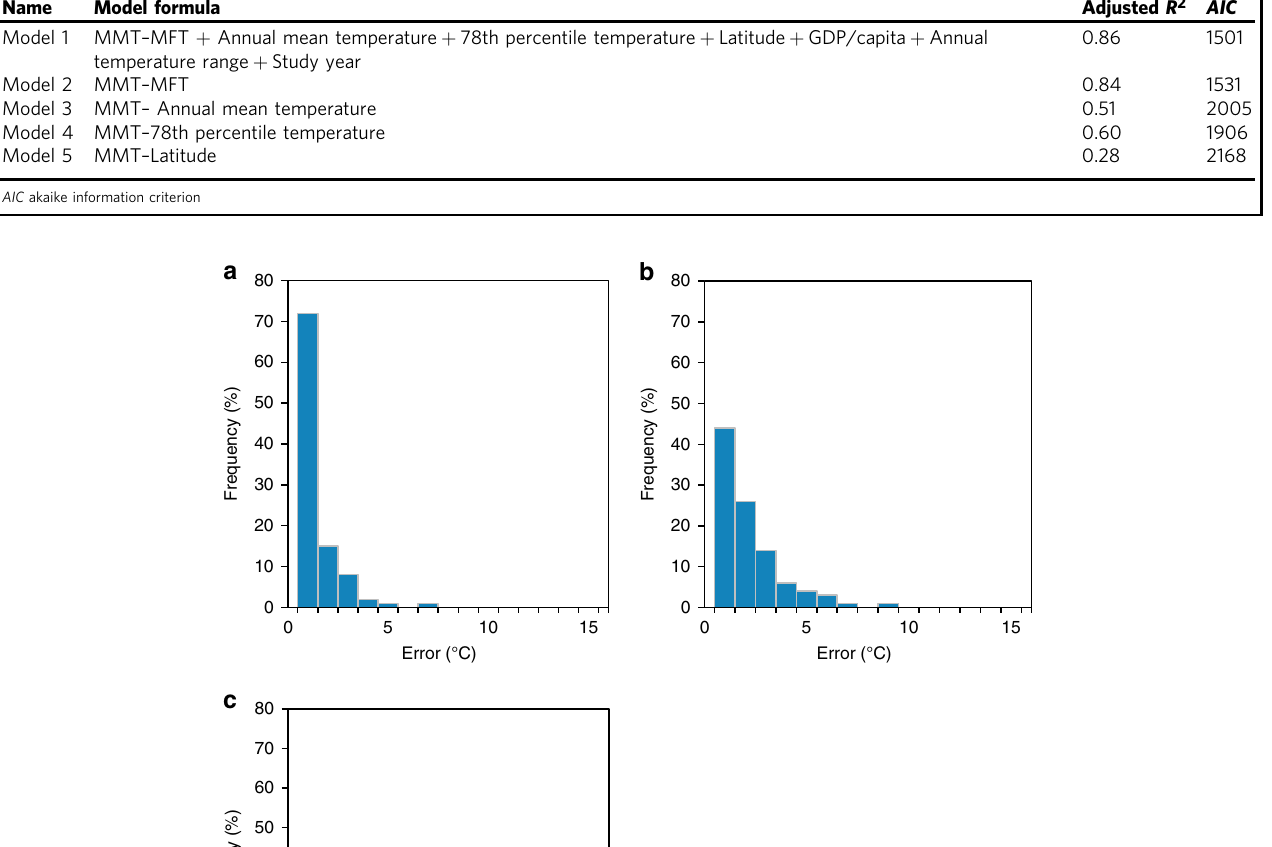
Table 2 The model and performance of multiple linear regressions Name